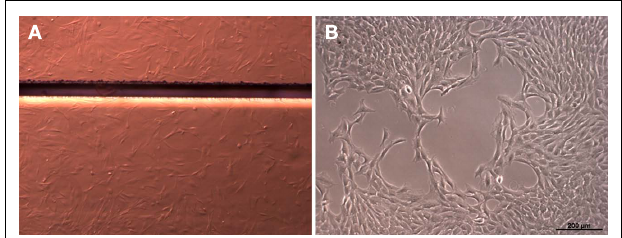
polyimide films.The horizontal bar shows a boundary between two polyimide pieces (Magnification 6 × , DiscoveryV.8; Carl Zeiss GmbH, Oberkochen, Germany). For normal cell culture plastic the cells are depicted by phase-contrast (Axiovert 40C, Carl Zeiss GmbH, Oberkochen,